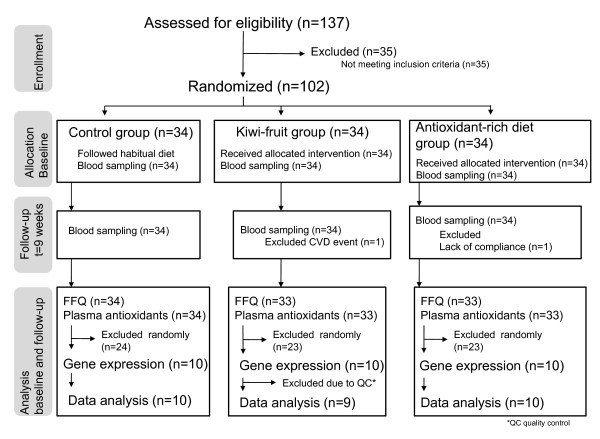
Participant flow.